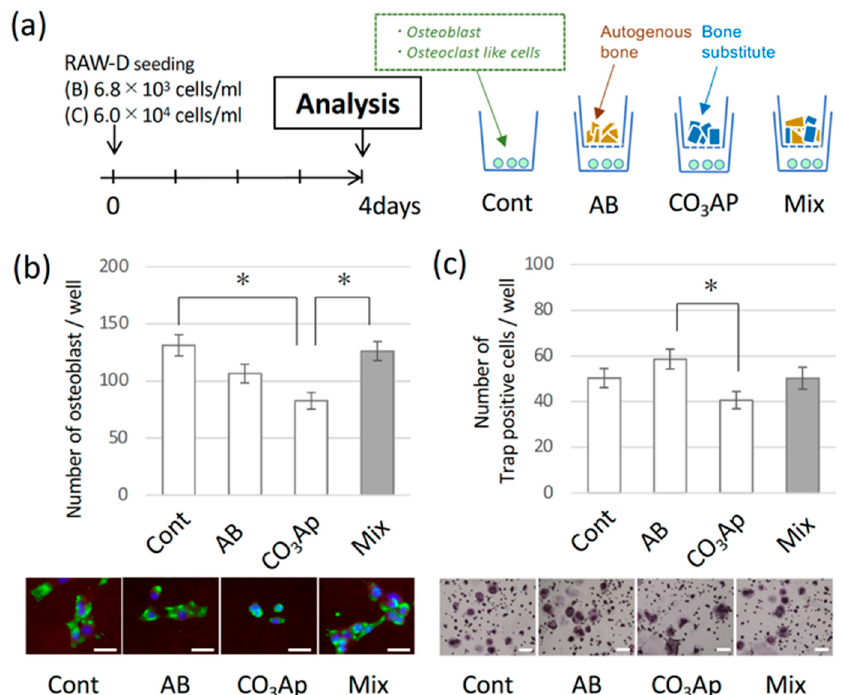
Figure 1. ( a ) Culture protocol. Osteoblasts from the rat bone marrow of a tibia were used, and RAW-D cells were used as osteoclast precursor cells. Autogenous bone (AB), carbonate apatite (CO 3 AP), and a mixture of AB and CO 3 AP (Mix) were placed in the upper well of a Transwell, and nothing was added to the control group (Cont). ( b ) Number of adhered osteoblasts after four days. Scale bar = 20 μm . ( c ) The number of TRAP-positive cells representing cells differentiated into osteoclasts. (* p < 0.05) Scale bar = 20 μm .